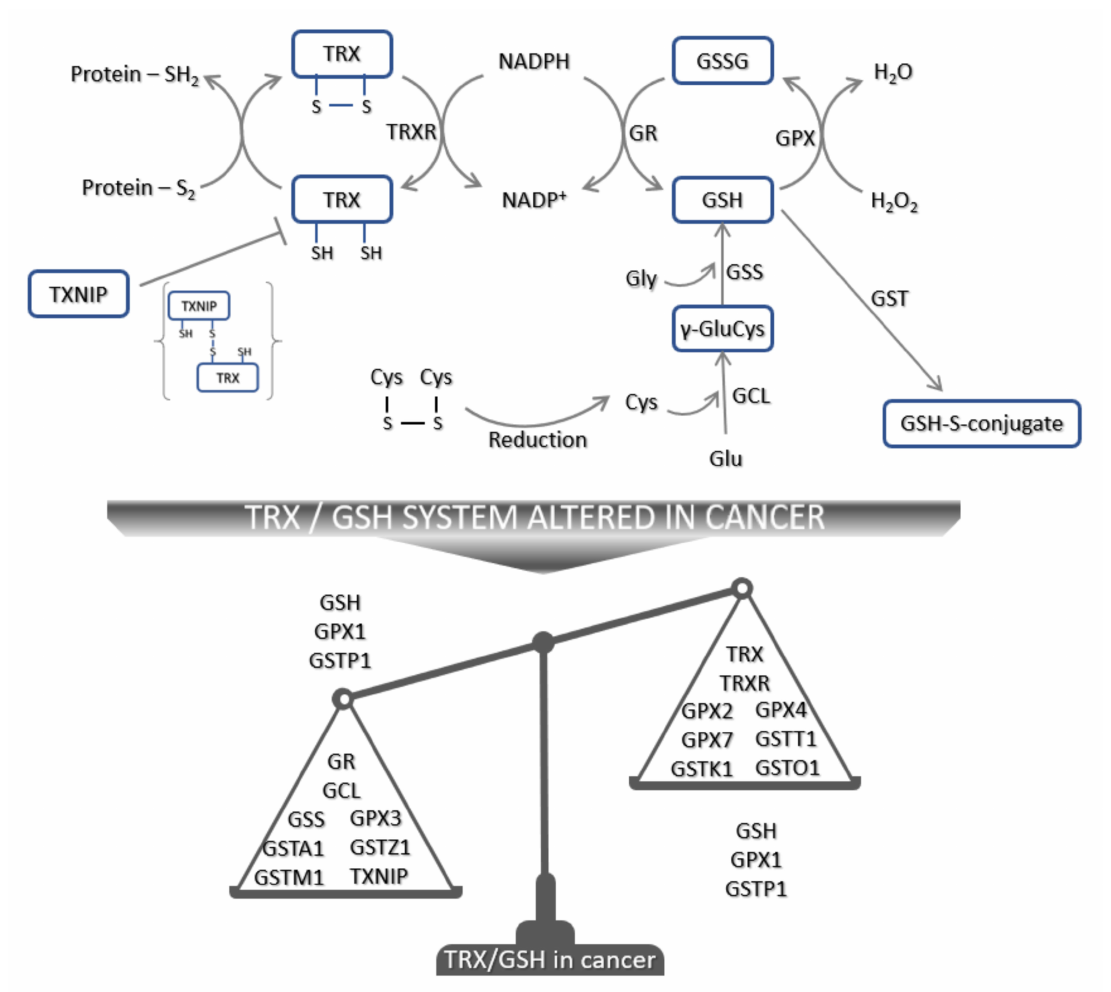
Figure 2. Schematic presentation of TRX and GSH antioxidant defense mechanisms. Oxidized TRX is reduced to the active reduced form of TRX by TRXR that uses NADPH as the main electron source. Reduced TRX reduces oxidized substrates. However, this can be inhibited by TXNIP, resulting in TXNIP-TRX complex formation. Moreover, extracellular cystine once imported in the cell can be reduced by the TRX system and used for GSH synthesis. GCL catalyzes the formation of γ -GluCys from Cys and Glu. Further addition of Gly by GSS produces GSH. During the detoxification of ROS, GSH is converted to GSSG and its recycling depends on GR and NADPH. In addition, during the detoxification of other molecules—e.g., 4-HNE—GSH conjugation by GST is the main step. In cancer, TRX and / or GSH systems are altered and their expression in